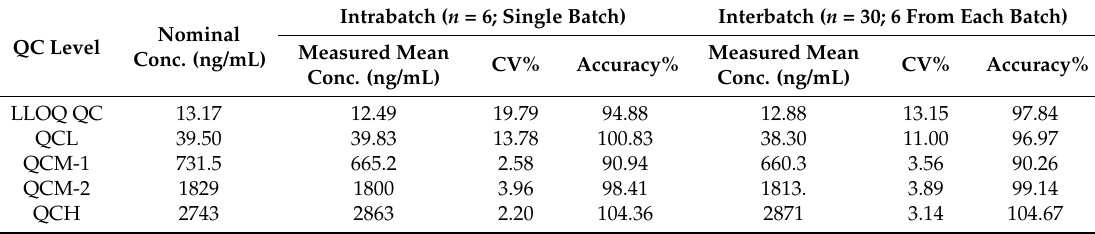
Table 2. Intra- and interday precision and accuracy of the method for determination of folic acid in human plasma.